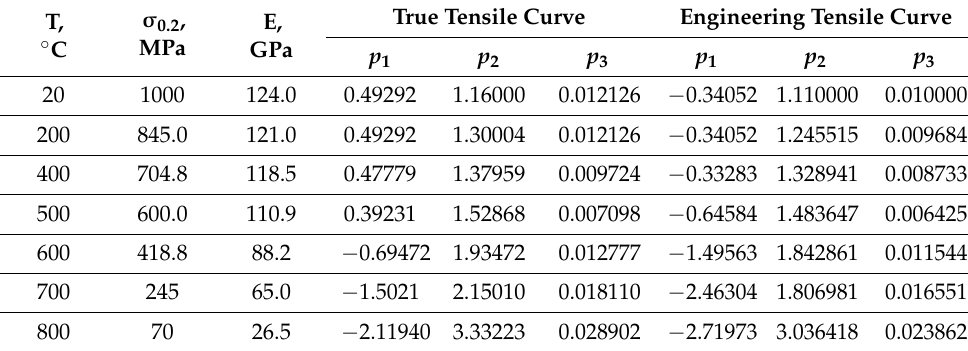
Table 1. Mechanical properties and fitting coefficients.